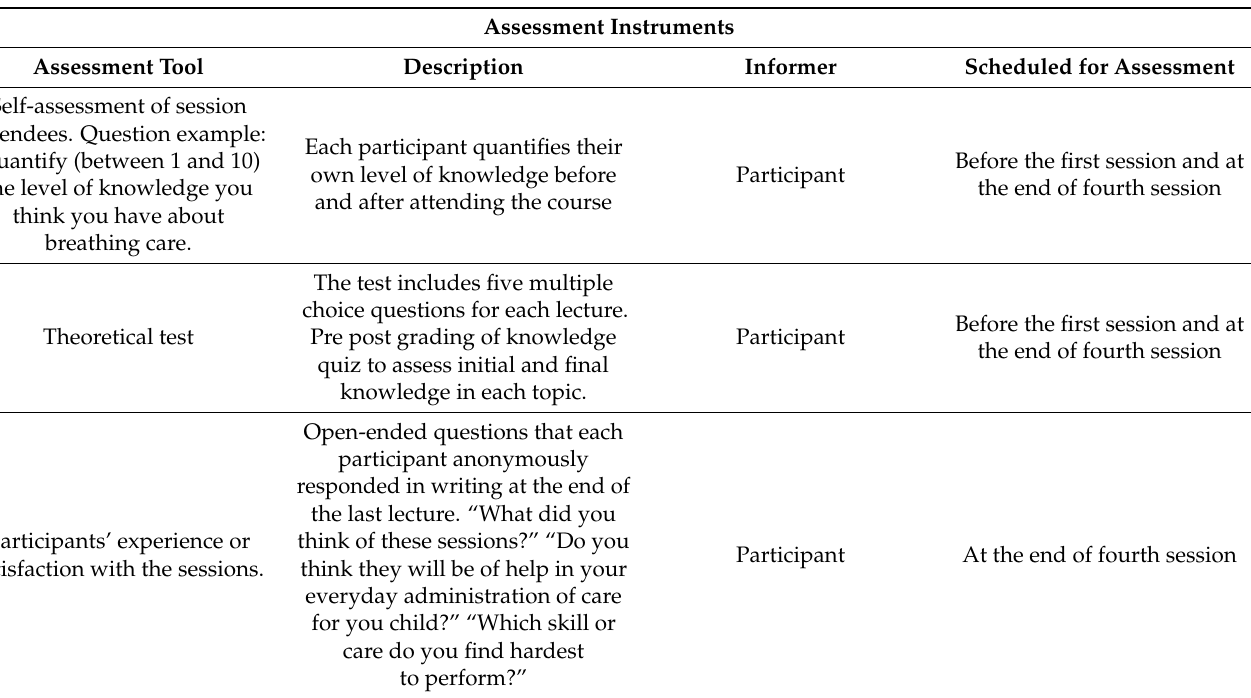
Table 2. Assessment